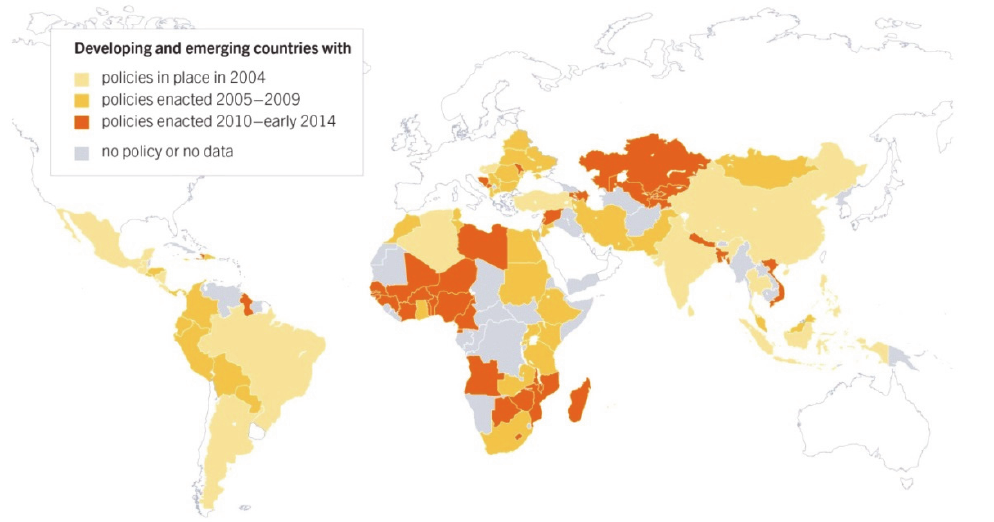
Fig. 2. Developing and emerging countries with renewable energy policies (REN21,